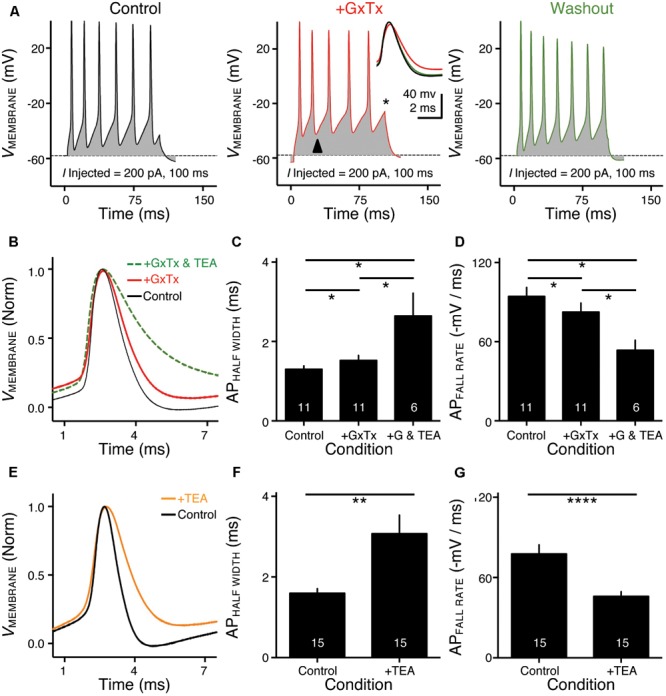
KV2- and KV3-containing channels regulate action potential (AP) kinetics for NMc neurons. (A) Representative membrane responses recorded from an NMc neuron in control, during application of GxTx and during washout process. The amplitude of current injection is 200 pA for 100 ms. Arrowhead points to the evident membrane depolarization during AP firing under GxTx. Asterisk denotes the failure of AP. Inset shows superimposed first APs under three conditions. (B,E) Representative APs with normalization (norm) in control and during drug application. GxTx, Guangxitoxin (100 nM). TEA, tetraethylammonium (1 mM). (C,F) Population data showing AP half width in control and during drug application. (D,G) Population data showing AP fall rate (in absolute value) in control and during drug application. G represents GxTx. Error bar = standard error. Numbers in bars represent sample size. ∗p < 0.05, ∗∗p < 0.01, ∗∗∗∗p < 0.0001.